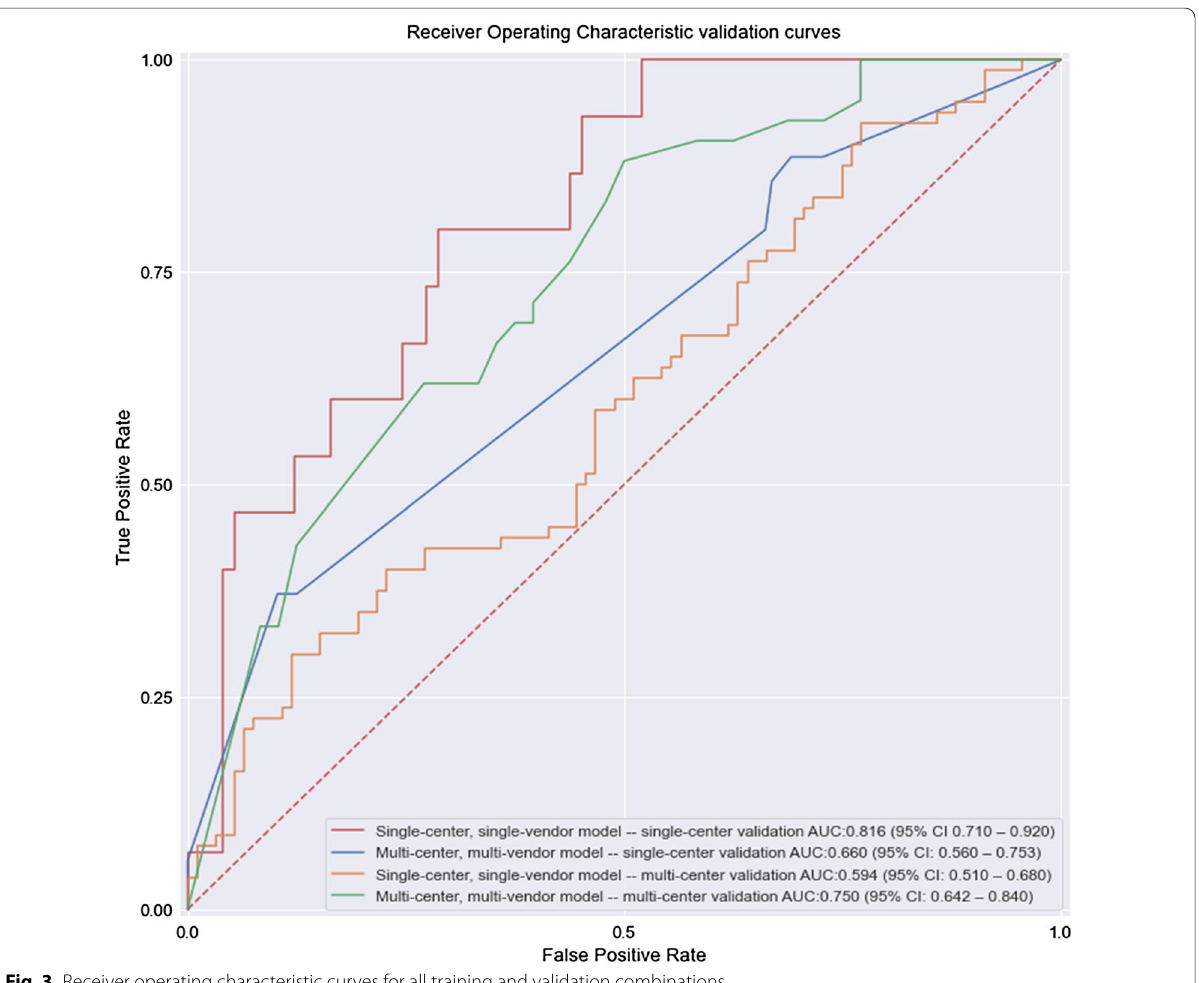
Fig. 3 Receiver operating characteristic curves for all training and validation combinations